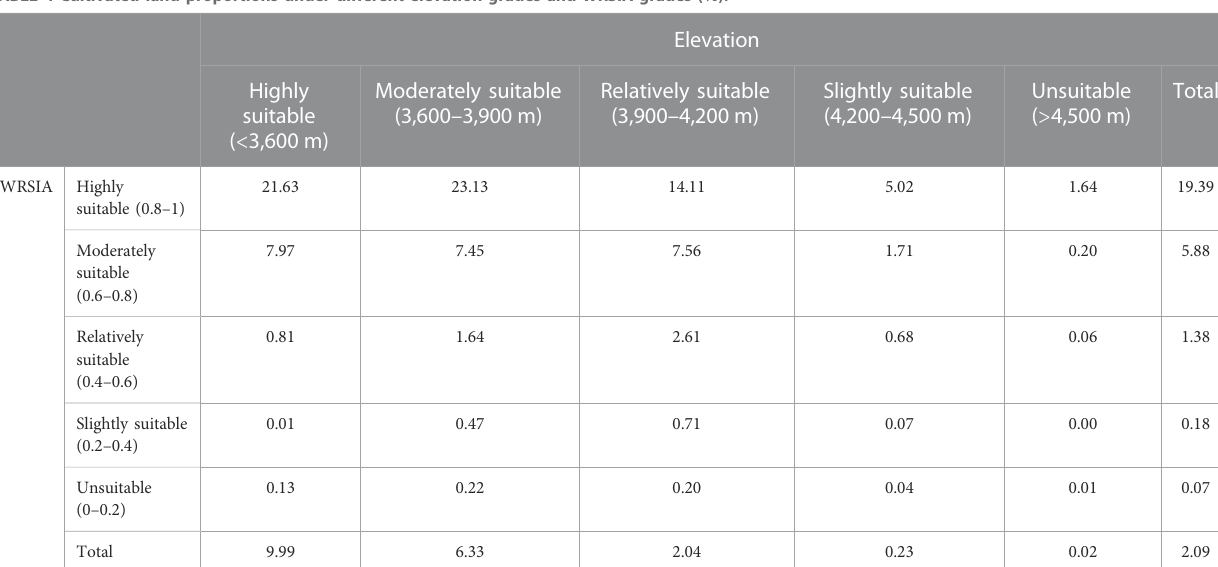
TABLE 4 Cultivated land proportions under different elevation grades and WRSIA grades